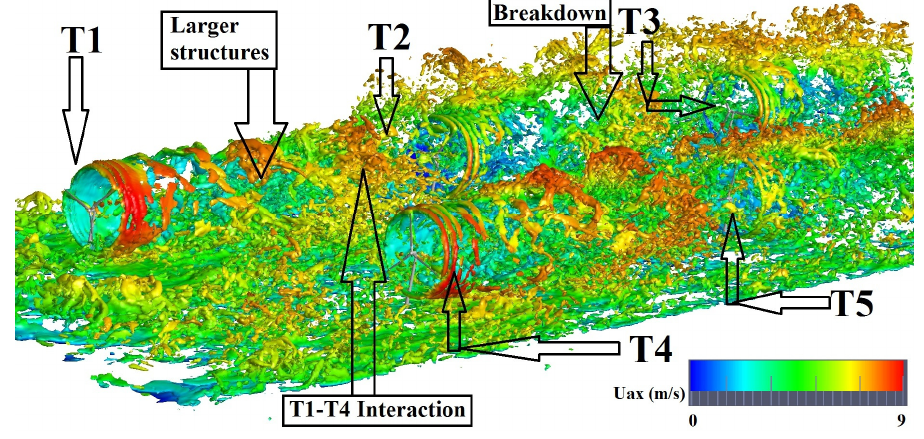
Figure 15. Five-Turbine Wind Farm in MCBL flow (NREL 5-MW Turbines, V Wind = 8